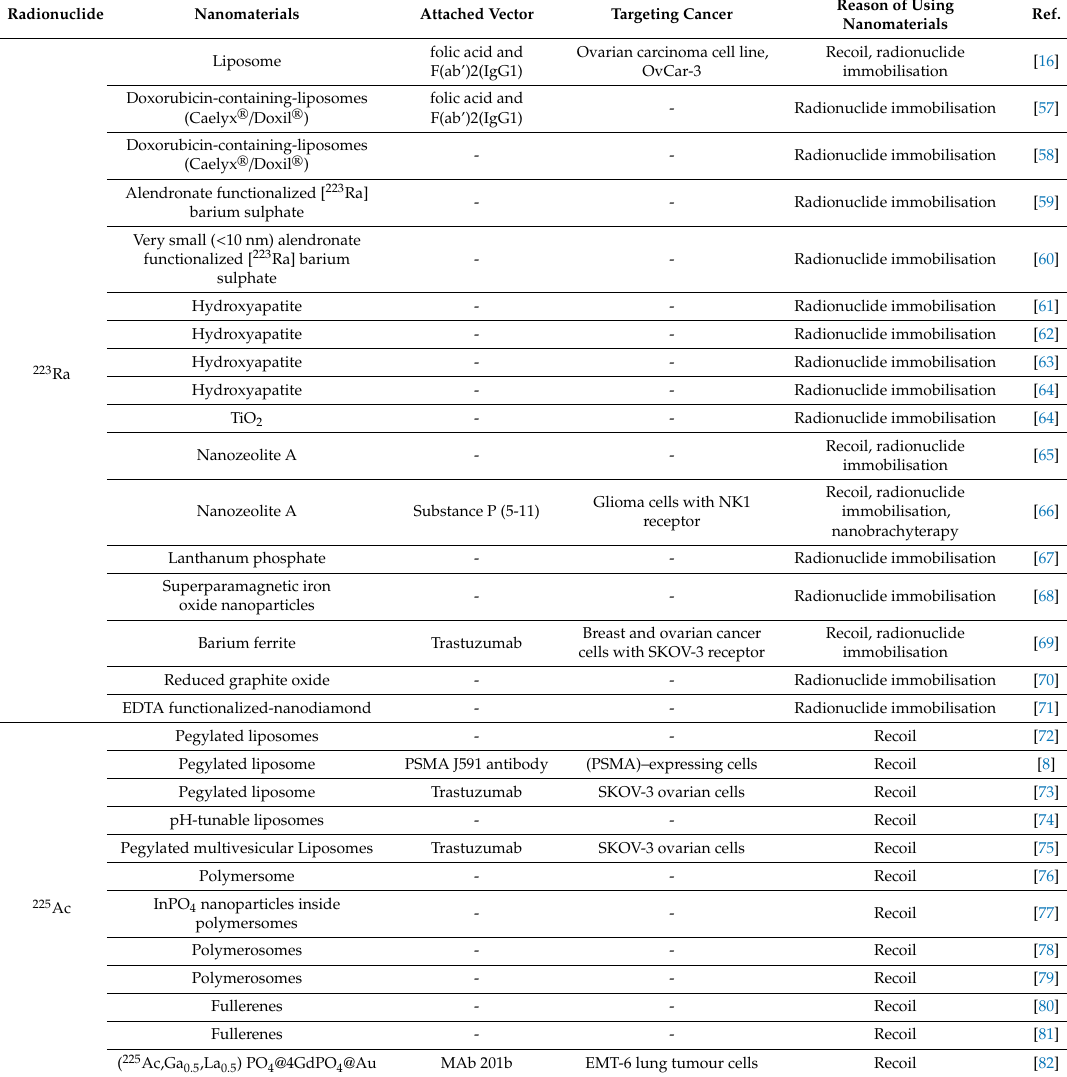
Table 2. Functional nanomaterials labelled with alpha-emitting